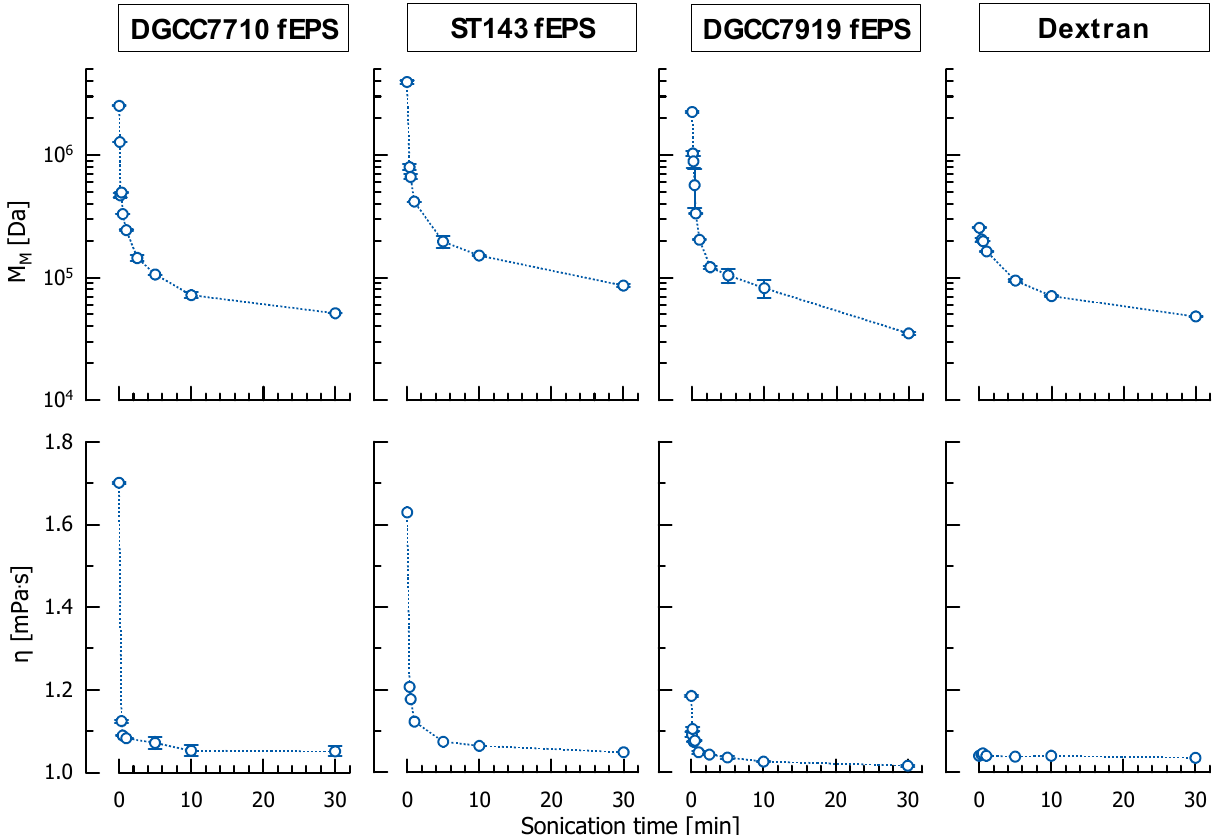
Figure 2. Weight average molecular mass M M of EPS and dynamic viscosity η of 1.0 g/L EPS solutions after sonication with an ultrasonic disintegrator (power density: 114 W/cm 2